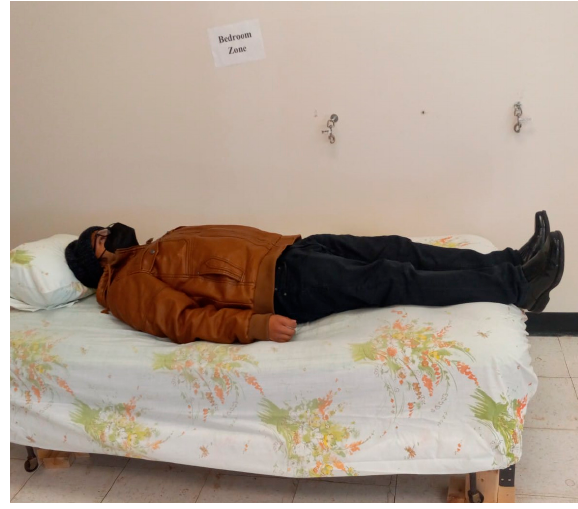
Figure 9. A participant sitting on a couch in the relaxation zone.